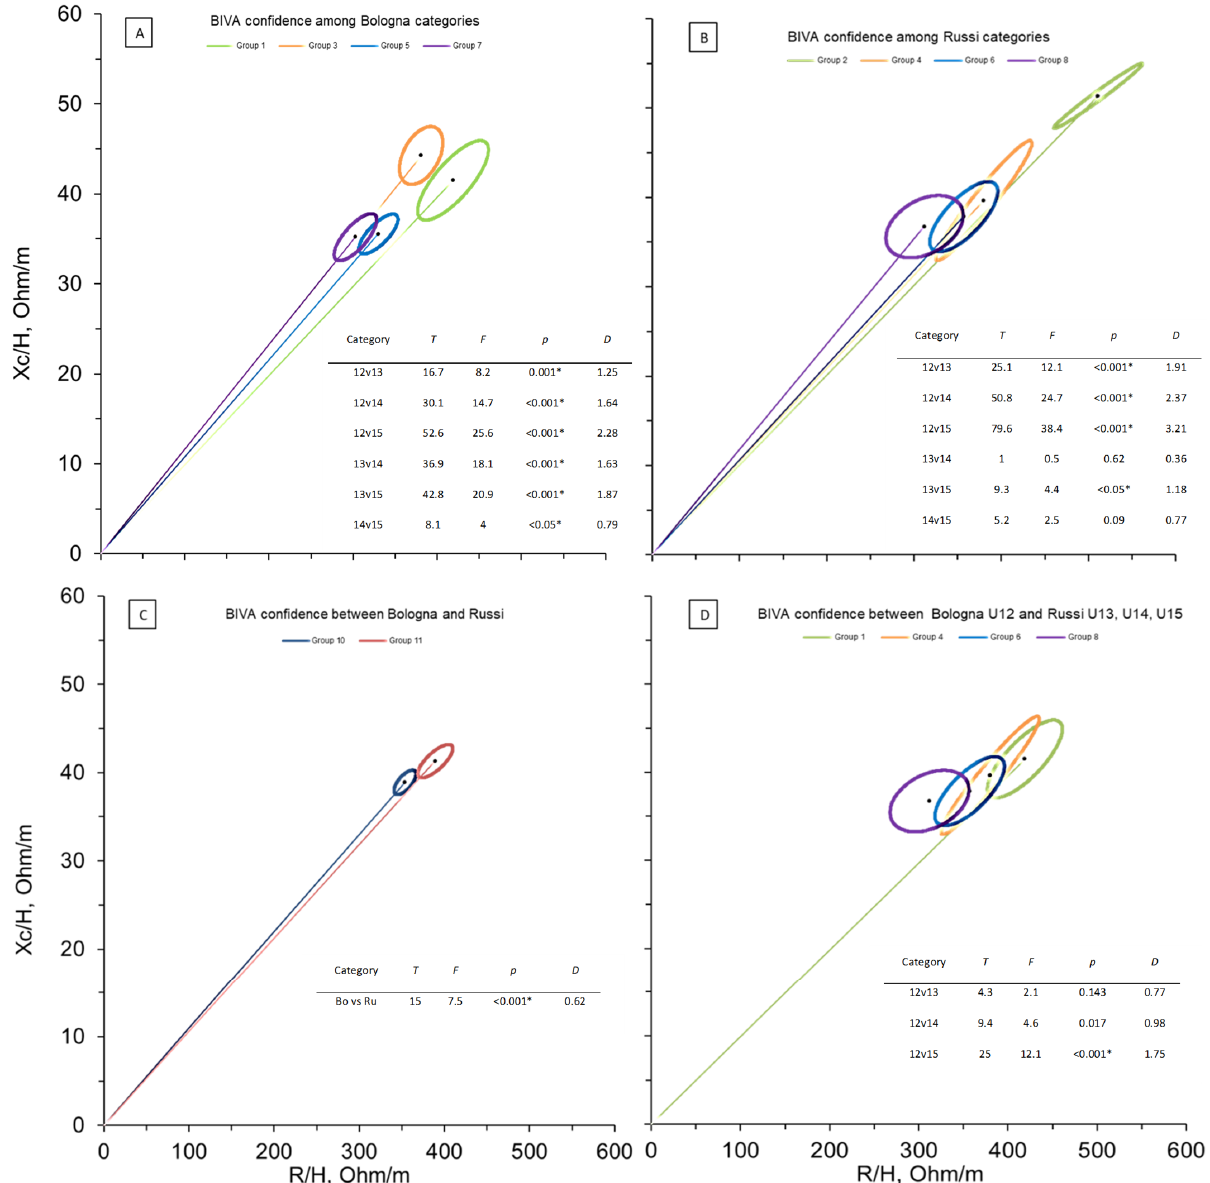
Figure 1. BIVA confidence among and between Bologna and Russi categories: ( A ) among Bologna categories (Group 1 = U12, Group 3 = U13, Group 5 = U14, Group 7 = U15); ( B ) among Russi categories (Group 2 = U12, Group 4 = U13, Group 6 = U14, Group 8 = U15); ( C ) between Bologna and Russi mean; ( D ) between Bologna U12 (Group 1) and Russi U13 (Group 4), U14 (Group 6), U15 (Group 8). Note: T , Hotelling T 2 ; F , Snedecor-Fisher test; p , p -value; D , Mahalanobis distance; *, statistically